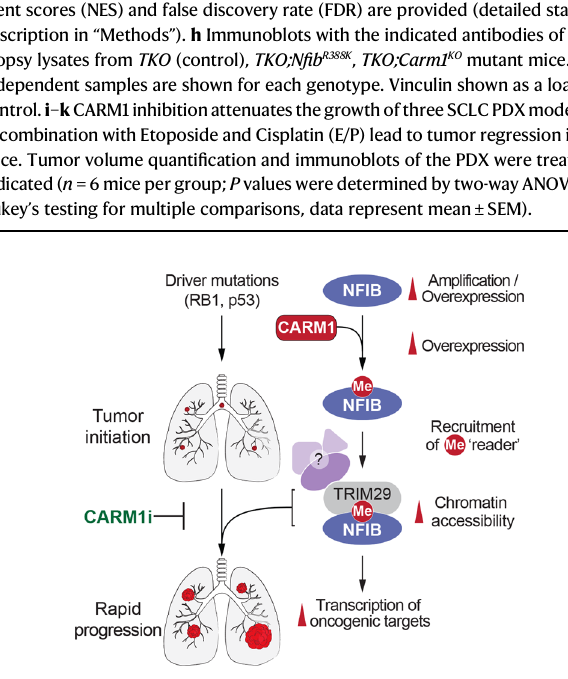
Fig. 4 | CARM1 methylation of NFIB regulates chromatin accessibility of SCLC cell to promote tumor growth. a – c ATAC-seq analysis of regions of differential chromatin accessibility in TKO (control) vs TKO;N fi b R388K vs TKO;Carm1 KO . d Correlation of differential chromatin accessibility between control, NFIB mutant and CARM1 knockout tumors collected from n =3 independent mice for each group. Pearson ’ s correlation coef fi cient ( r ) was calculated. e Correlation of differ-